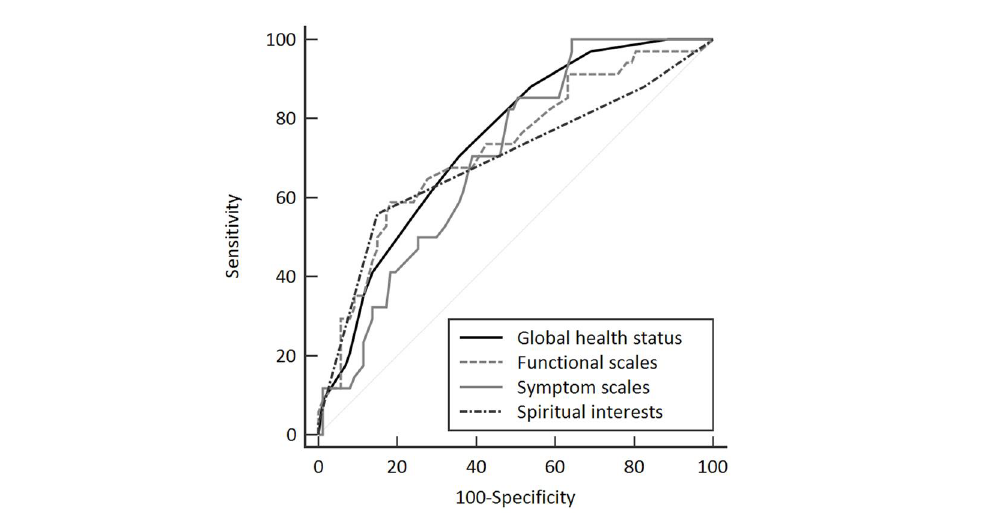
Figure 1. Receiver operating characteristic curve analysis of the scores of European Organization for Research and Treatment of Cancer Quality of Life Questionnaire (EORTC QLQ-C30) and spiritual interests (total scores of Spiritual Interests Related to Illness Tool Chinese Version) for demoralized patients. Global health status is the total scores of EORTC QLQ-C30. Table 3. Univariate and multivariate analyses of demoralization in all